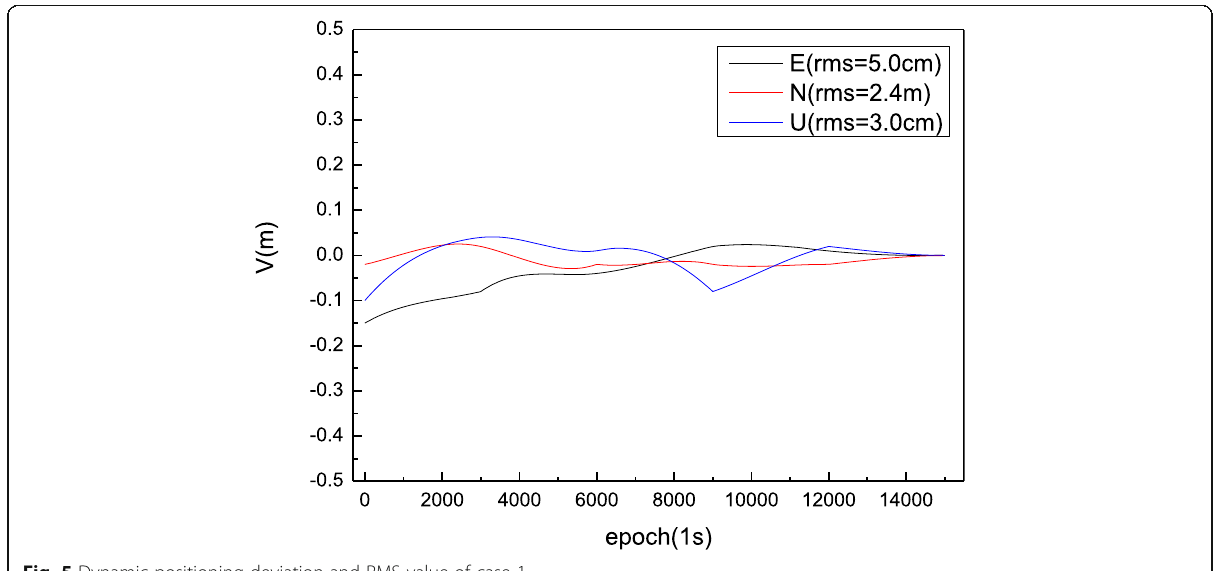
Fig. 5 Dynamic positioning deviation and RMS value of case 1